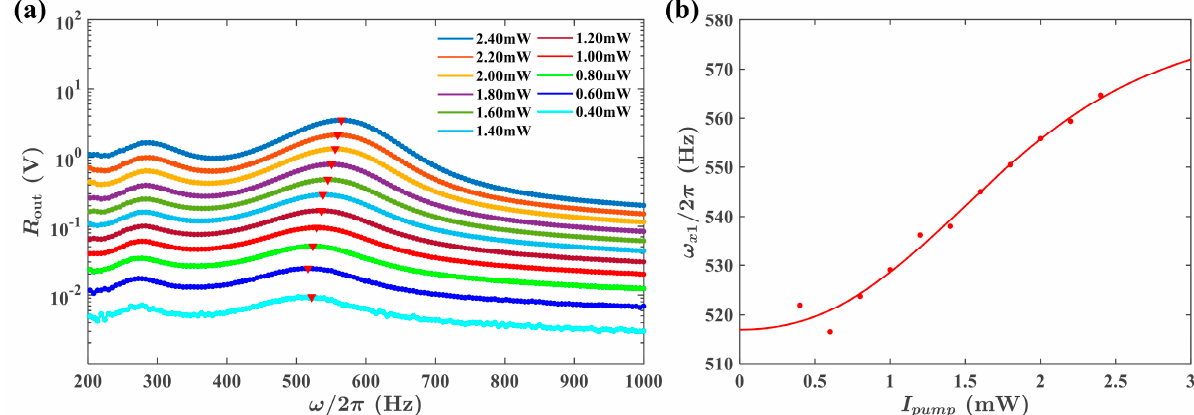
Figure 6. ( a ) Magnetometer response to different frequencies of the modulated magnetic field and with different pump light powers I pump (plotted using different colors). Each peak of magnetometer response of R at the first-order resonance is marked with a red inverted triangle and recorded. ( b ) The plotted ω x 1 /2 π under different I pump , wherein each record is extracted from the data depicted in ( a ). This plot indicates the relationship between ω x 1 /2 π and I pump , and, moreover, the fit value of ω x 1 for I pump → 0 can be acquired.